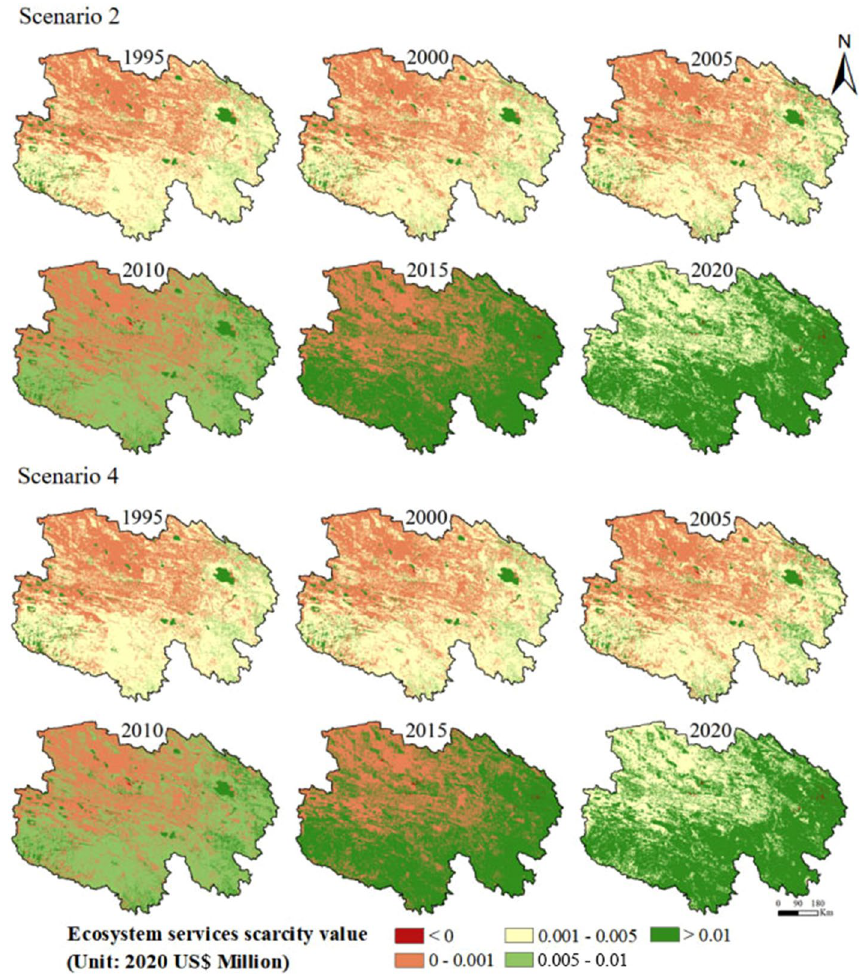
Figure 6. Spatial distribution of the ESSVs for scenario 2 and scenario 4 (made in ArcGIS 10.4.1, https:// www. esri. com/ zh- cn/ arcgis/ produ cts/ arcgis- deskt op/ resou